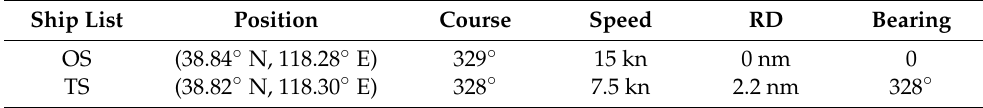
Table 3. Initial information (overtaking).